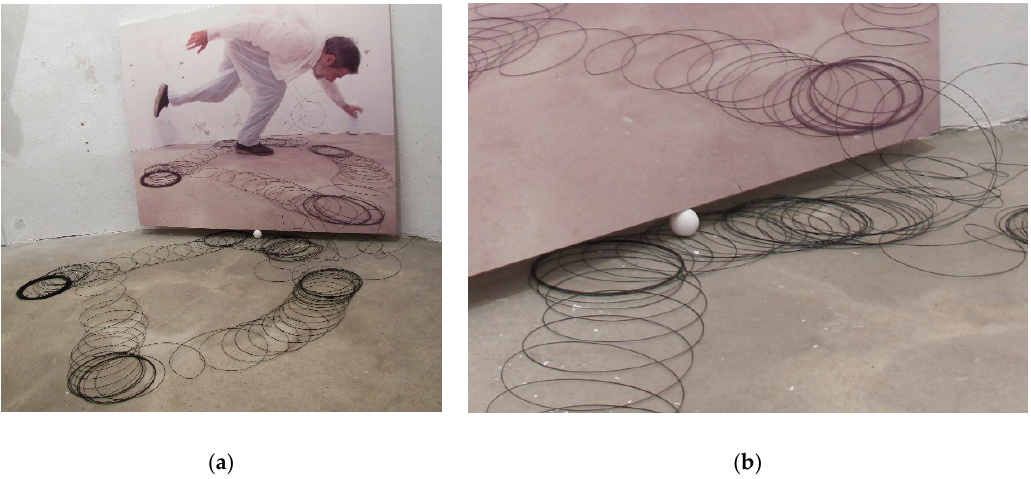
Figure 4. Peter Tzanev, Ectoplastic exercises: ( a ) Out-of-Body Experience, 2018; ( b ) Out-of-Body Experience, (detail), 2018; photos: P. Tzanev, 2018. Arts 2019 , 8 , x FOR PEER REVIEW